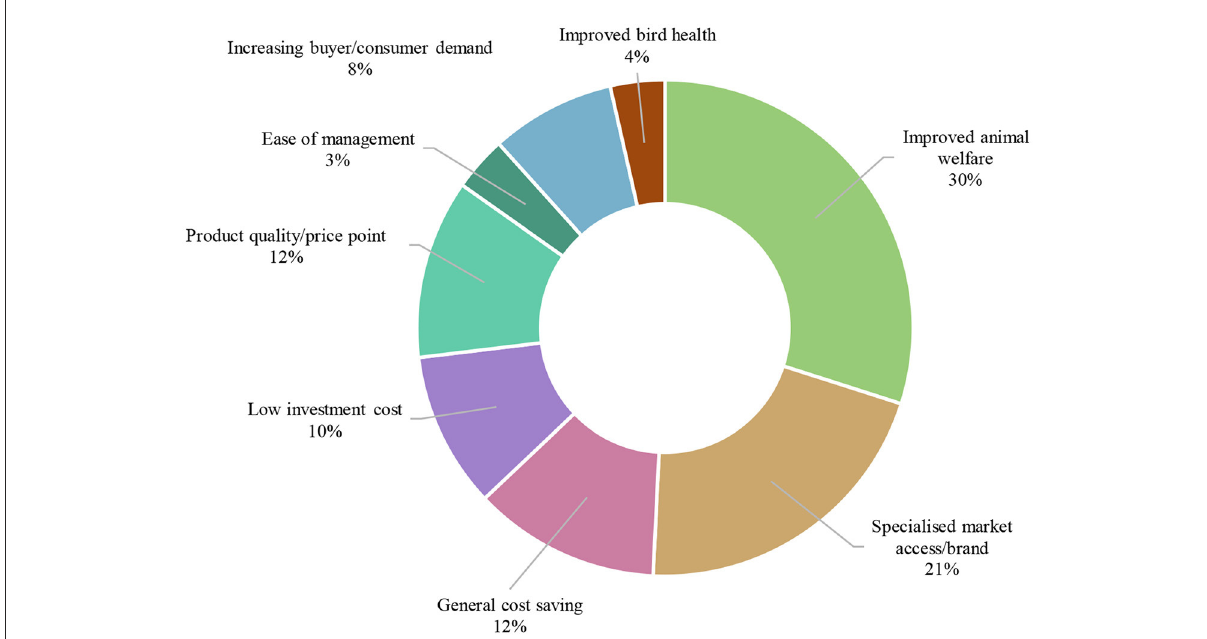
FIGURE2 Cage egg producers’ perceived reasons to adopt cage-free systems across all